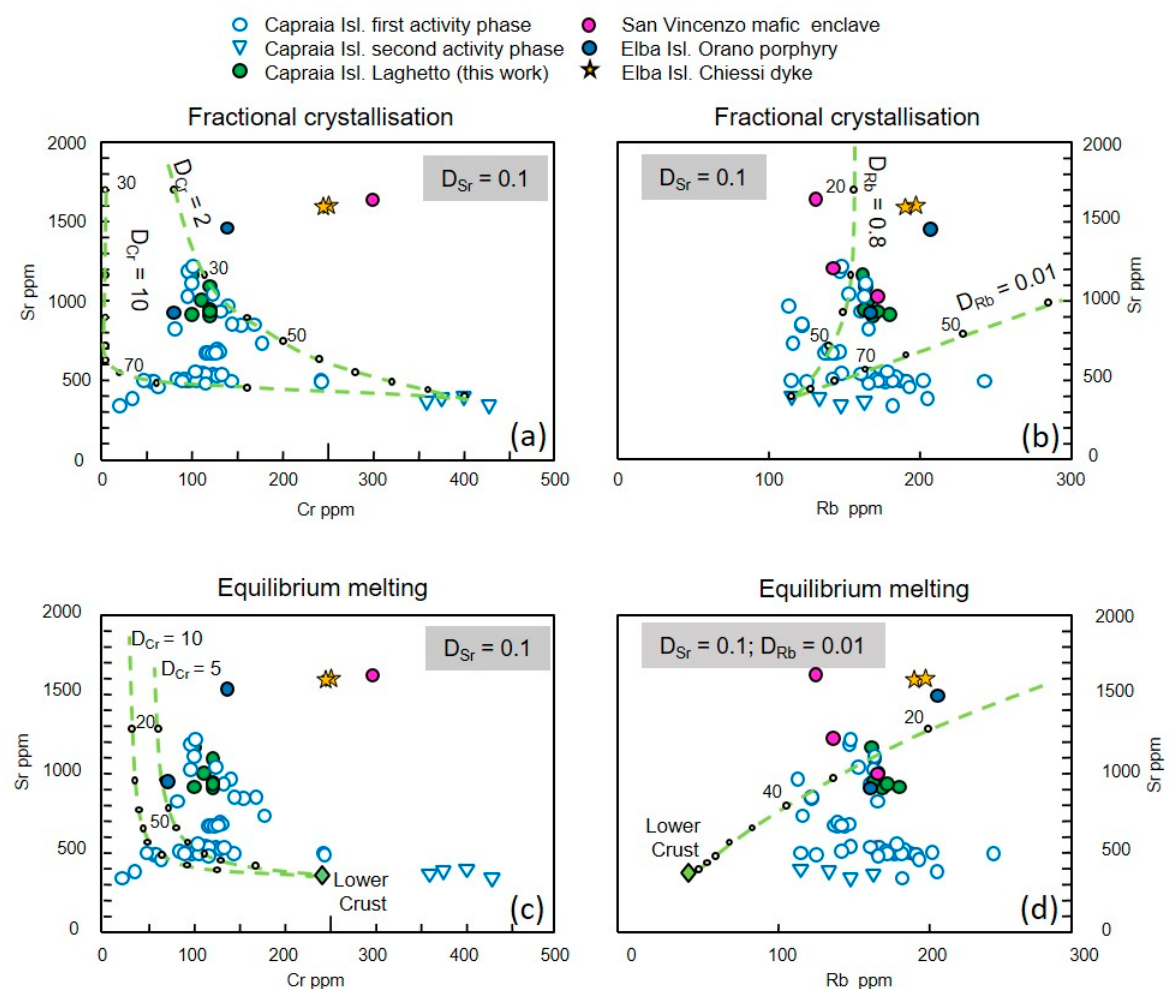
Figure 11. Model of fractional crystallisation and equilibrium melting for the Laghetto magmas . ( a , b ) Fractional crystallisation models from Capraia Zenobito basalts; ( c , d ) Batch melting model of lower crust. Numbers along lines indicate amount of liquid. Some Elba dykes [15,35] and mafic enclaves from San Vincenzo [16,34] are also plotted for comparison. For further explanation, see text.